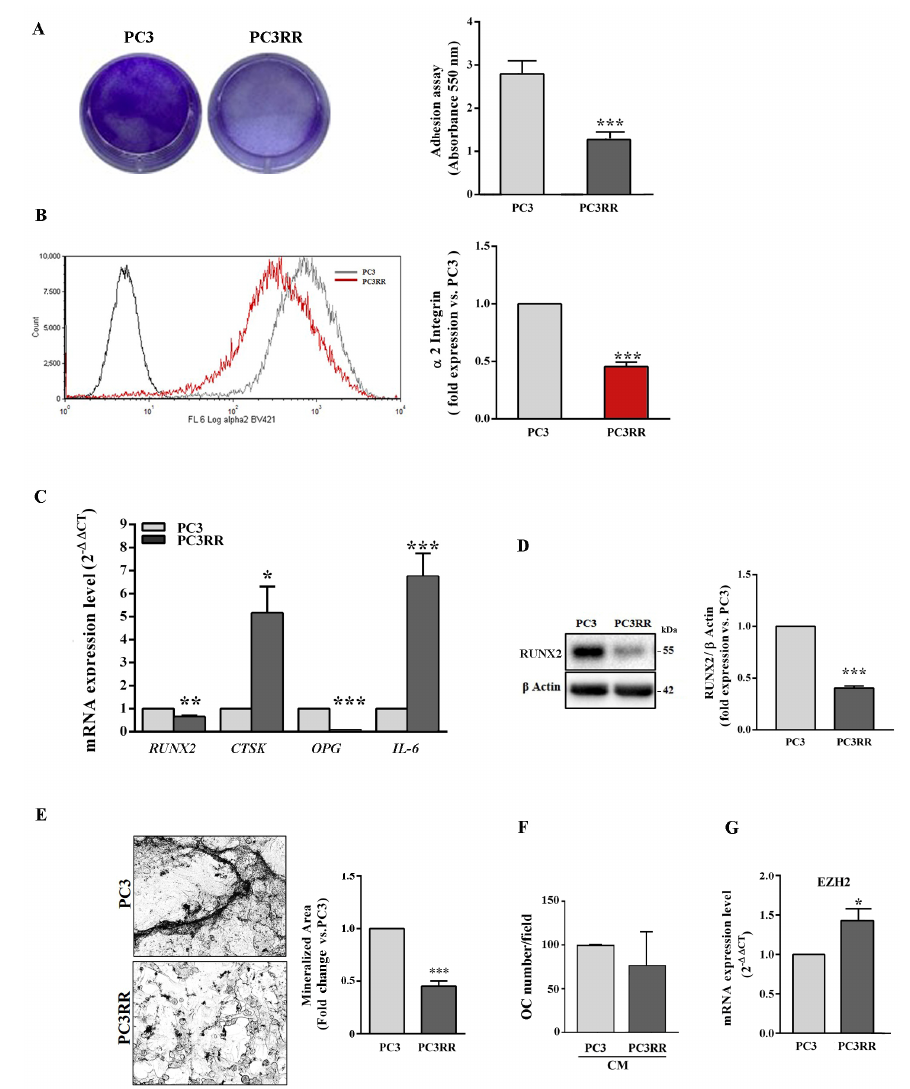
Figure 10 . Analysis of genes involved in osteomimicry and functional assay for osteoblast-like activity of PC3 and PC3RR cells. ( A ) Representative wells coated with type I collagen, on which a equal number of PC3 and PC3RR cells were cultured for 90 min and stained with crystal violet. After cell detaching, the absorbance was read using a spectrophotometer. It is shown in the histograms. ( B ) The graph represents the fold expression of the α 2 subunit of the integrin receptor, in which the median of fluorescence of parental PC3 cells is set as one (right). Representative flow cytometry histograms are shown (left). ( C ) The histograms represent RT-qPCR analysis of genes involved in osteoblast and osteoclast differentiation and function. ( D ) Representative blot of RUNX2 (left). The graph shows fold increase of RUNX2/ β -Actin ratio of PC3RR cells vs.PC3 (right). ( E ) Representative image of PC3 and PC3RR cells ability to release mineralized nodules, revealed by Von Kossa staining (left). The graph represents the fold of the mineralized area with parental PC3 value set as one (right). ( F ) Effect of conditioned medium from PC3 and PC3RR cells on the osteoclast differentiation of PBMCs isolated from 13 healthy donors. PBMCs were cultured in the presence of 50% conditioned medium (CM) obtained from PC3 and PC3RR cultures. After 14 days, the number of multinucleated TRAcP positive cells was evaluated. The results are expressed as a percentage vs. osteoclast number obtained from the differentiation of PBMCs in the presence of CM from PC3. ( G ) RT-qPCR analysis of EZH2 expression levels in PC3/PC3RR. All data represent the mean ± S.E.M. derived from at least three independent experiments. Statistical analysis * p < 0.05; ** p <0.01; *** p < 0.001; PC3RR vs.